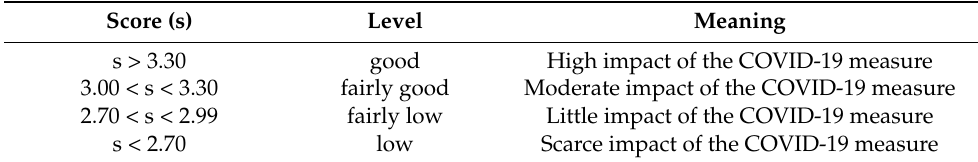
Table 3. Criteria used to evaluate the mean scores resulting from the COVID-19 questionnaire. Score (s)